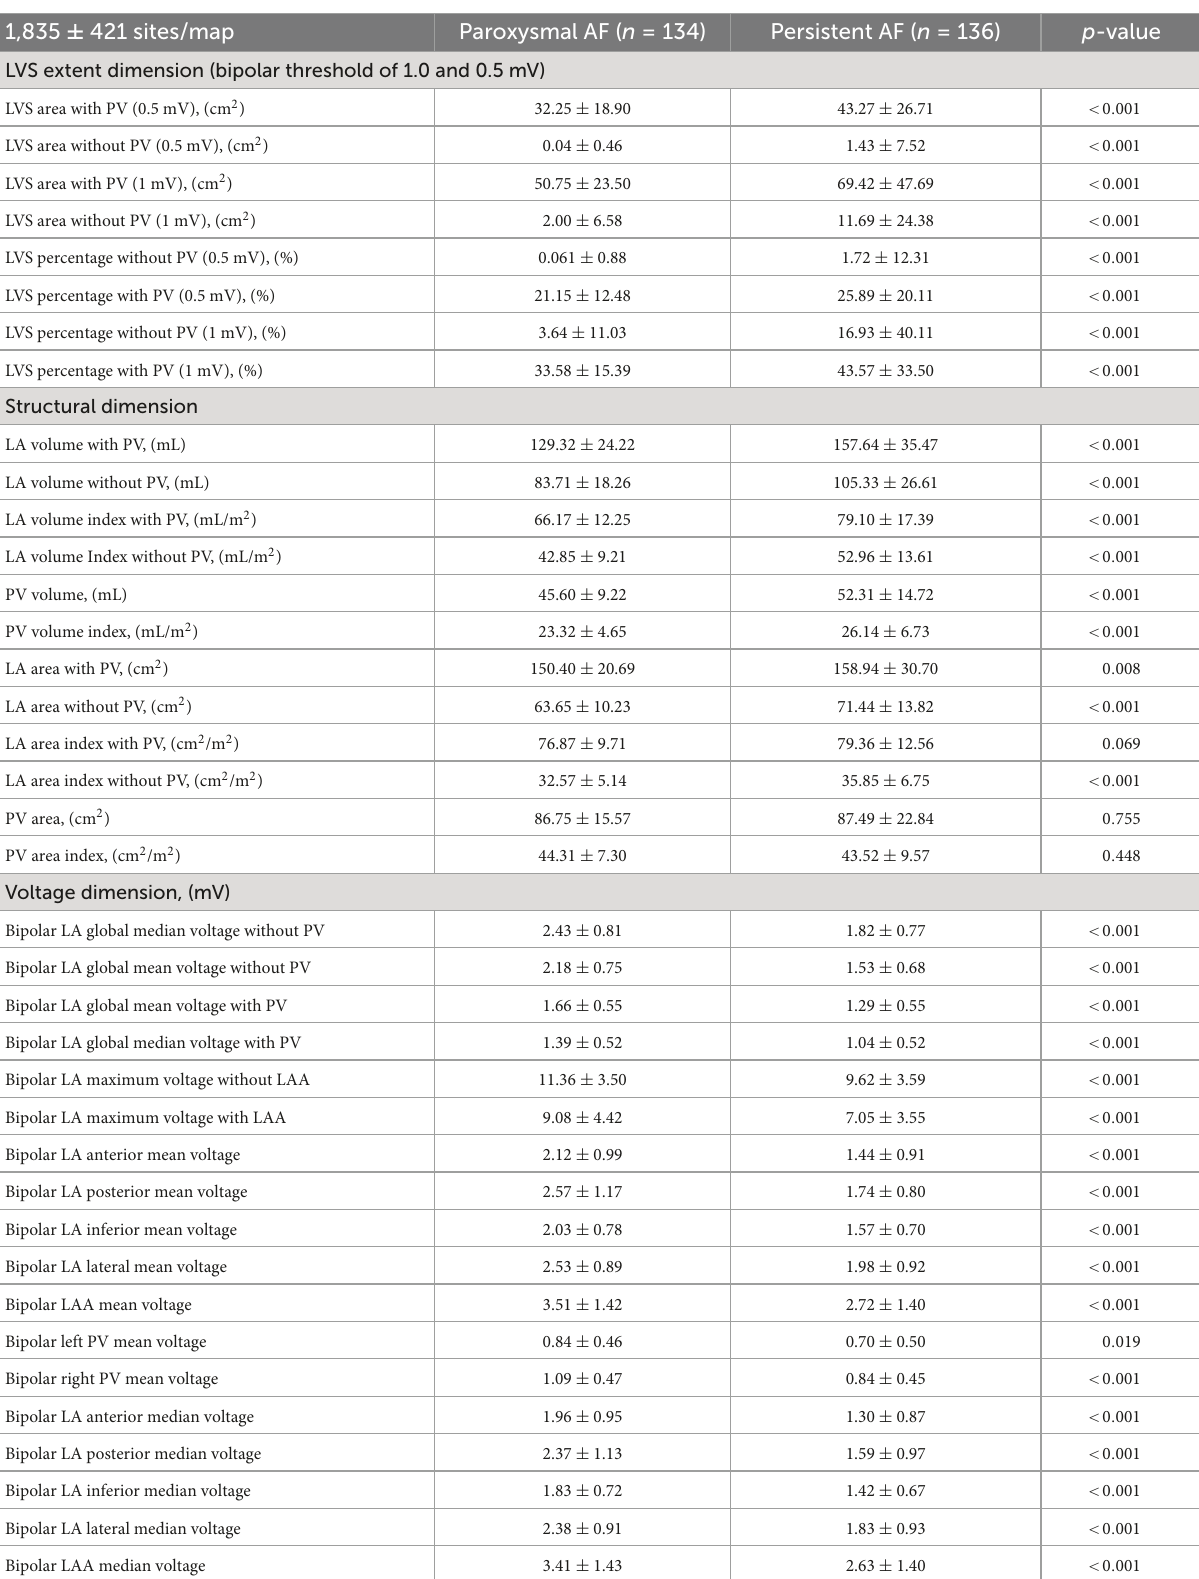
TABLE 2 Electro-anatomical characteristics between paroxysmal AF cohort and persistent AF cohort. 1,835 ± 421